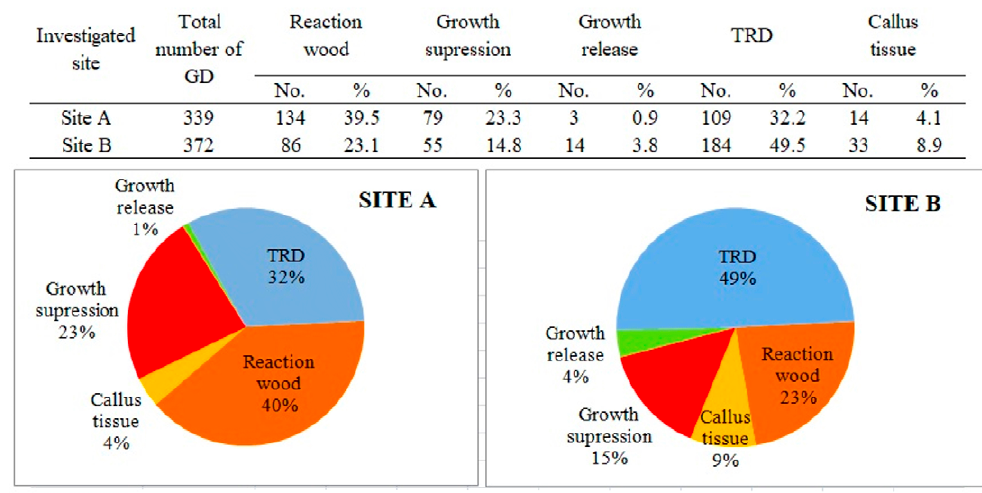
289 Geographica Pannonica • Volume 26, Issue 3, 284–296 (September 2022)